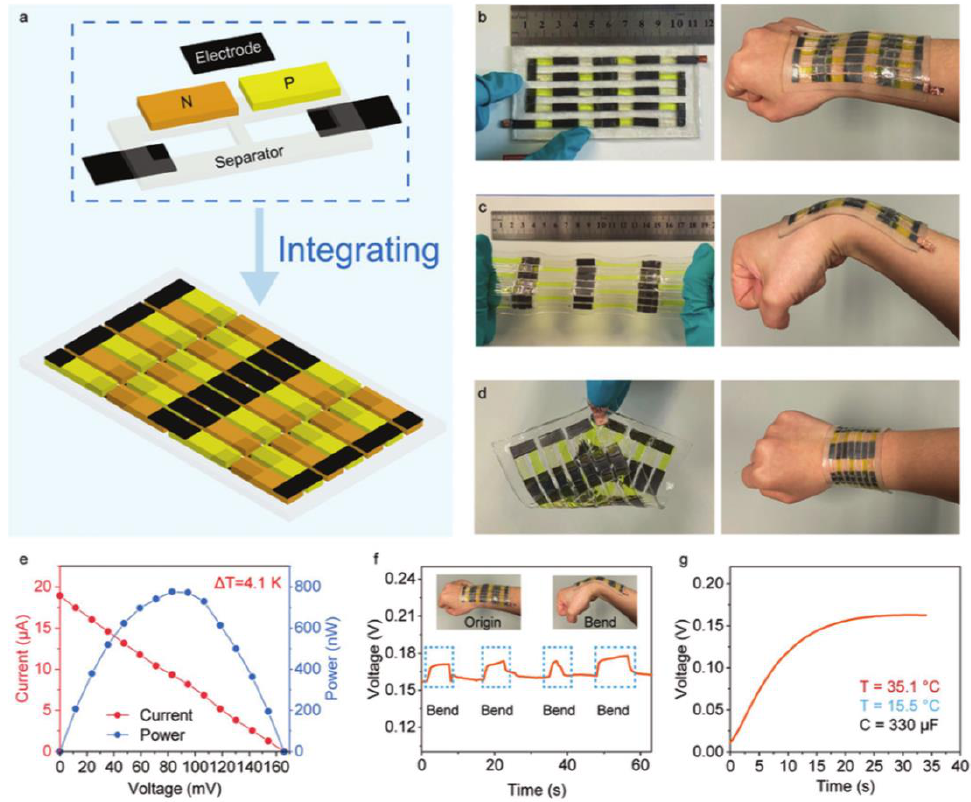
Figure 13. Wearable hydrogel thermocell for energy harvest. ( a ) Illustration of the integration of stretchable thermocell device. ( b – d ) Photos of the thermocell device attached to the human body undergoing different deformation states: ( b ) original state, ( c ) stretch-and-bend deformation, ( d ) fit to the curved surface. ( e ) The thermoelectric performances of a device integrating 14 pairs of p-n